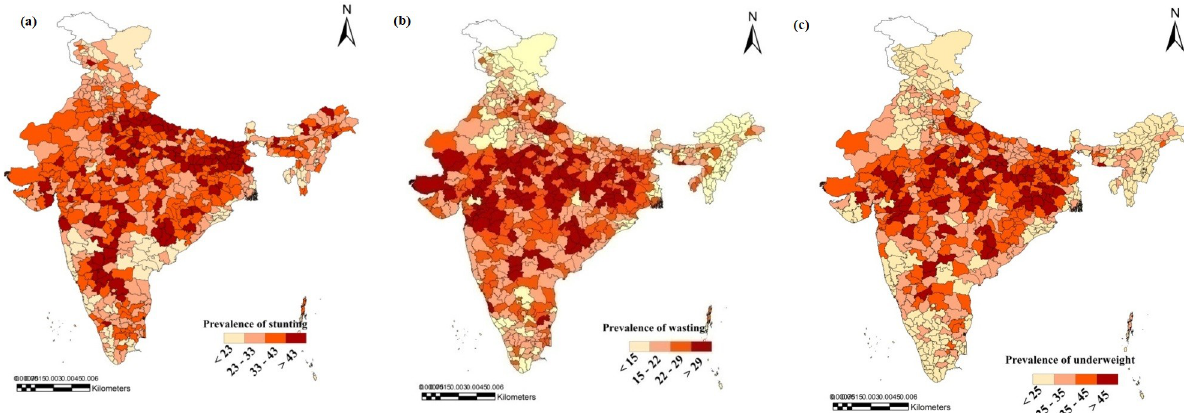
Fig 2. Prevalence of malnutrition a) Stunting, b) wasting, c) underweight for all districts, India, 2015–16.